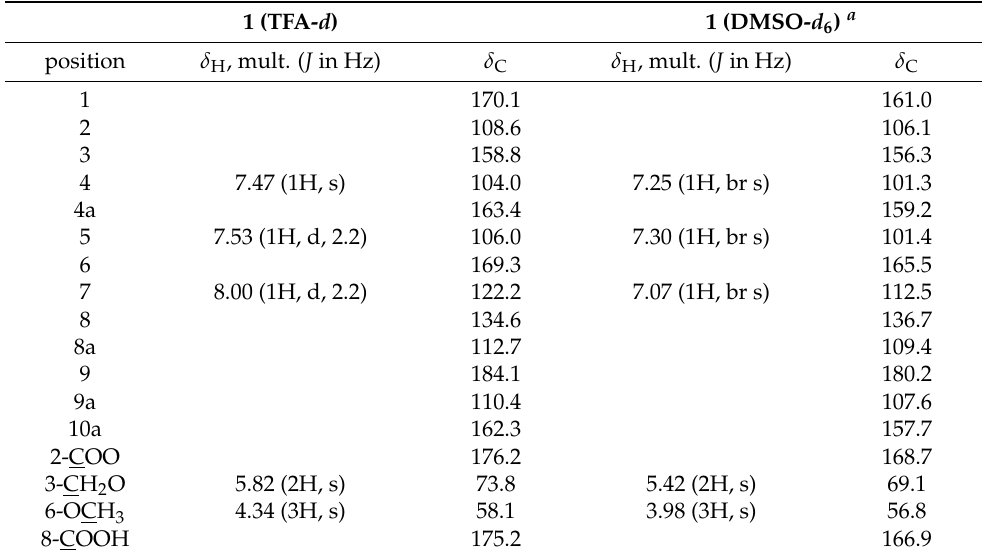
Table 1. 1 H and 13 C NMR (700/175 MHz) Spectroscopic Data for 1 .